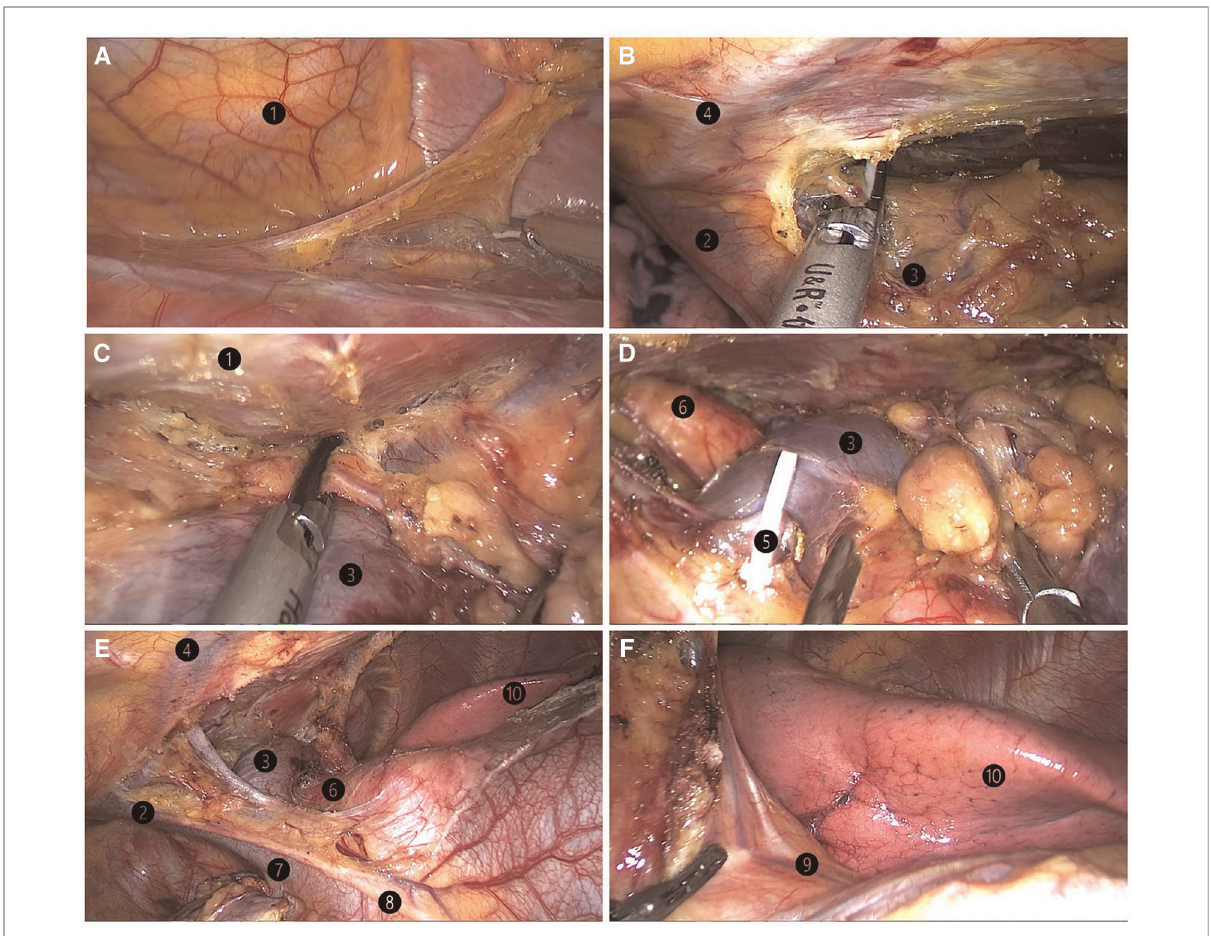
FIGURE 3 ( A ) lifting of the lower pole of the thymus with the grasping forceps. ( B ) Dissection of the right upper thymic lobe. ( C ) Dissection of the left upper thymic lobe. ( D ) Resection of the thymic vein. ( E ) Skeletonization of both innominate veins, the superior vena cava, and the aorta. ( F ) Left lung and left phrenic nerve. ❶ sternum; ❷ right brachiocephalic vein; ❸ left brachiocephalic vein; ❹ internal thoracic artery and vein; ❺ thymic vein; ❻ aorta ascendens; ❼ superior vena cava; ❽ right phrenic nerve; ❾ left phrenic nerve; ❿ left